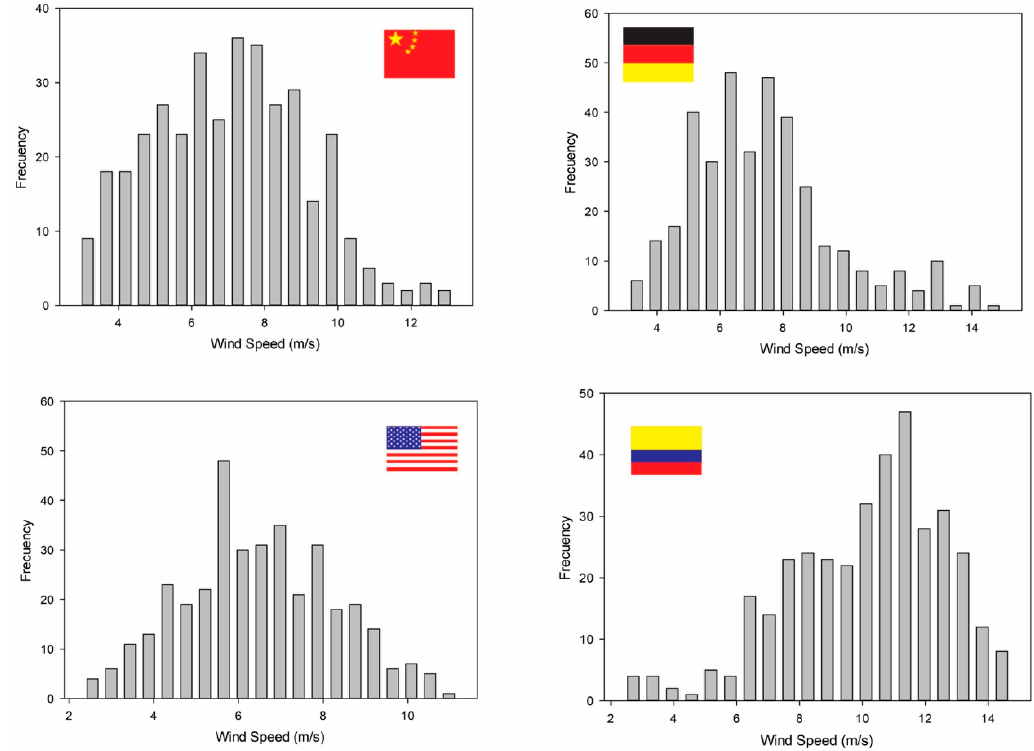
Figure 4. Frequency distribution of wind speed for each location.